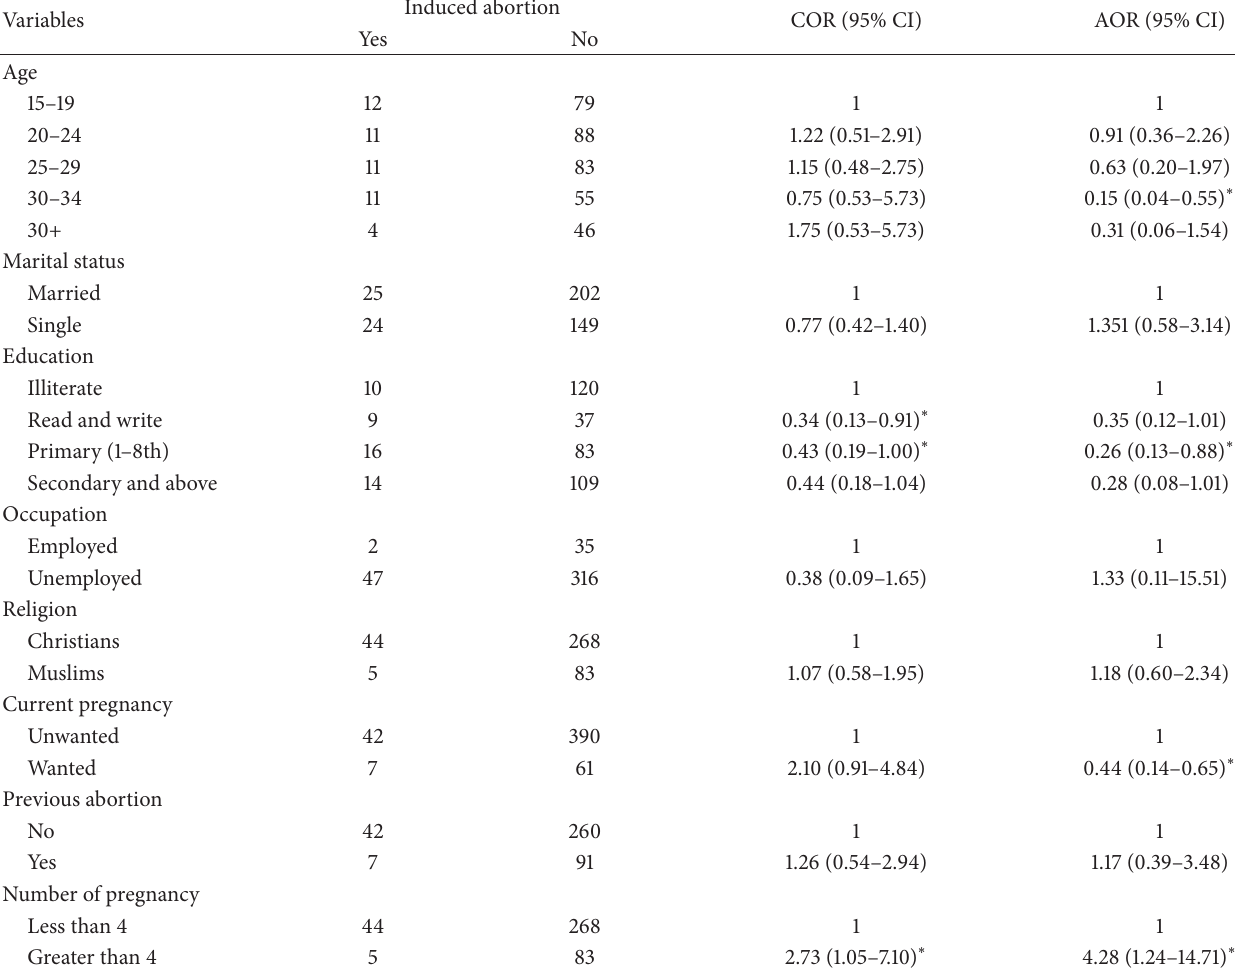
Table 5: Factors associated with induced abortion in health institutions of Guraghe zone, South Ethiopia from January to March 2010.